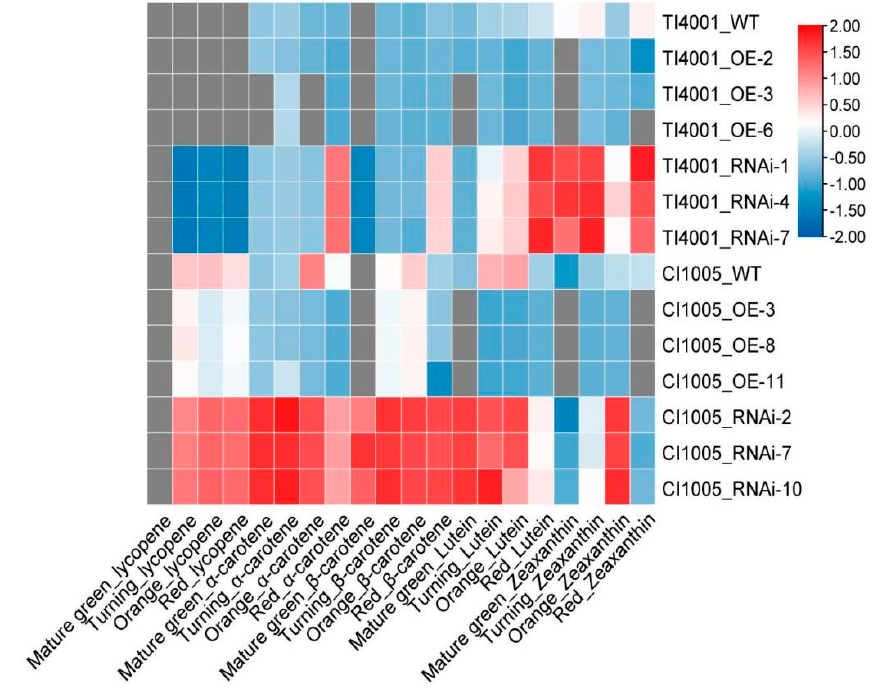
Figure 14. Effects of SlCCD1A on the carotenoid contents in tomato fruits.